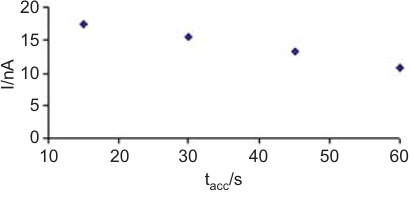
HPO (0.1 m ) – Na B O (0.1 m ) (25:25, v/v). 2 4 2 4 7